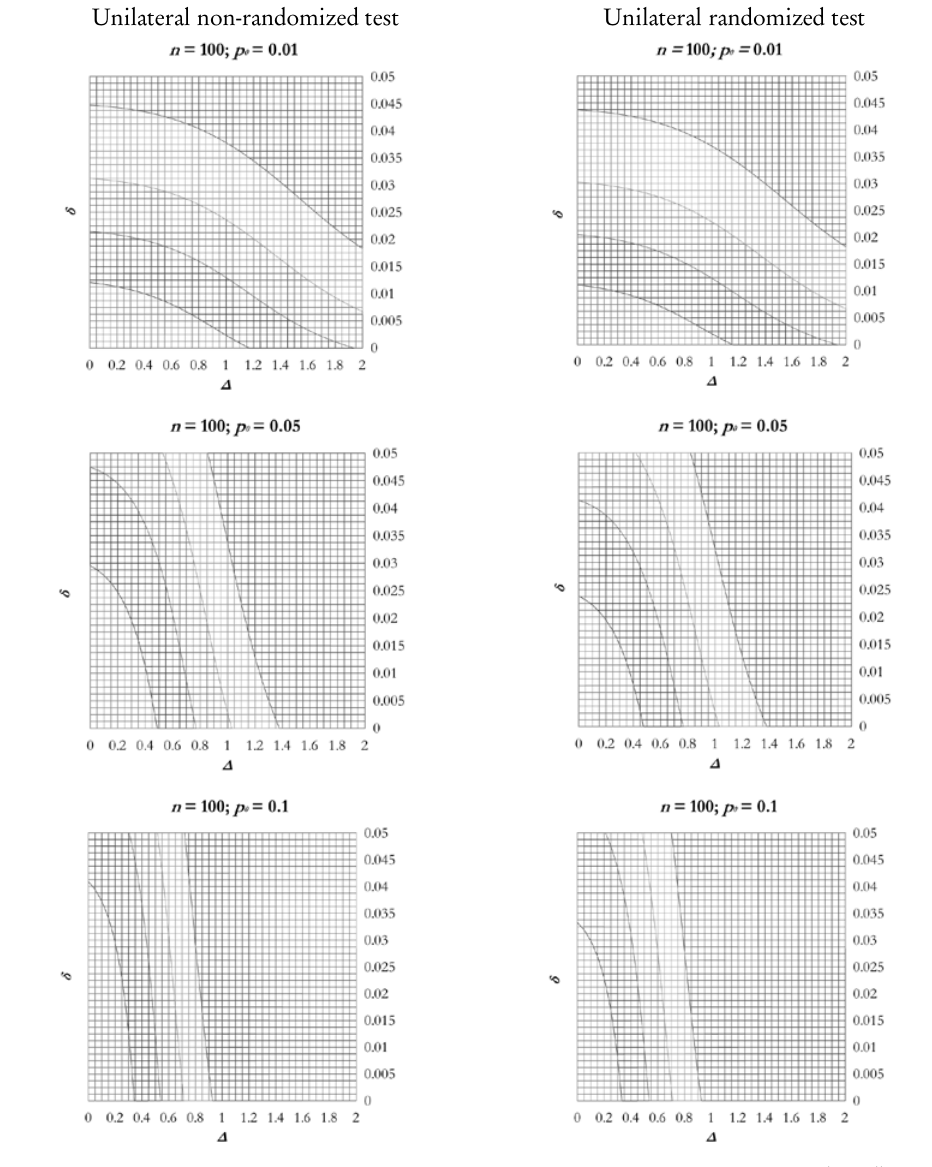
Figure 3 – Level curves for the unilateral non-randomized and randomized test for ' '' 2.5% α α= = ; 0.01, 0.05, 0.10 = . n 100 = and p 0 For n 250 = we have the following level curves for the non-randomized and for the randomized